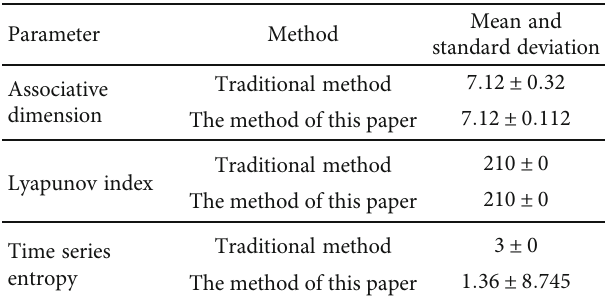
Figure 5: Genetic analysis of the volatility of time series entropy. Table 2: Comparison results of the three parameters with traditional